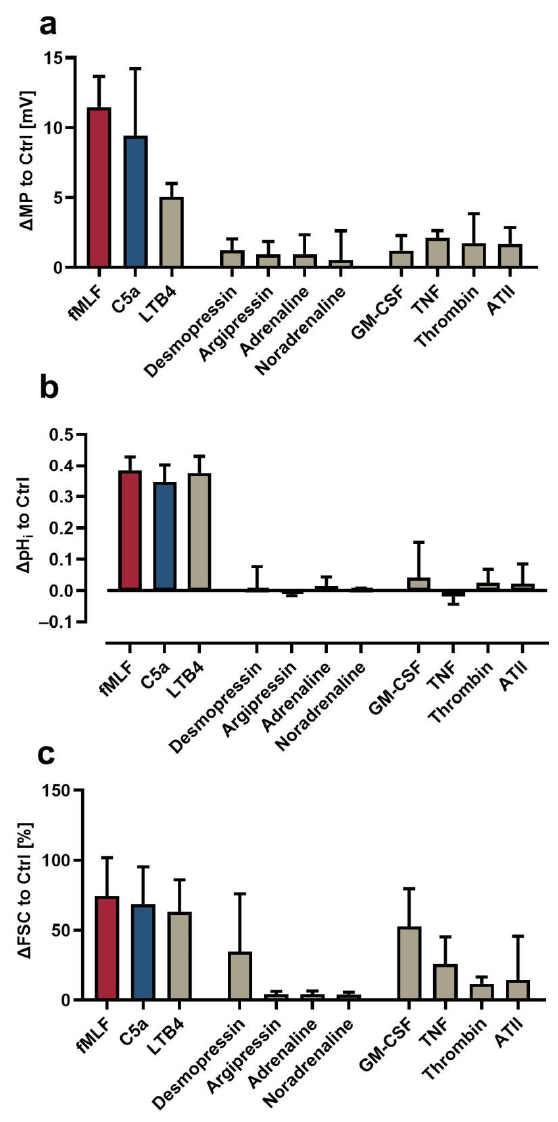
Figure 4. Effects of various sepsis-related mediators including chemoattractants, catecholamines, and other mediators on neutrophils presented at the time of their respective peaks within the first 10 min as determined for fMLF. ( a ) MP after 1 min, ( b ) pH i , after 5 min, and ( c ) FSC after 10 min of stimulation ( n =